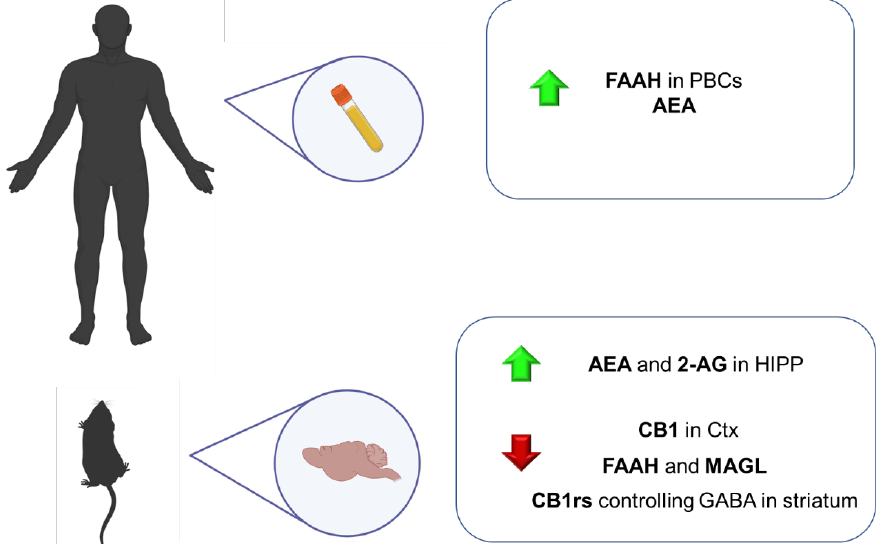
Figure 6. Main findings regarding the alterations of the ECS components in animal models and patients with attention deficit hyperactivity disorder. AEA: anandamide; CB1r: cannabinoid receptor 1; FAAH: fatty acid amide hydrolase; HIPP: hippocampus; Ctx: cortex.